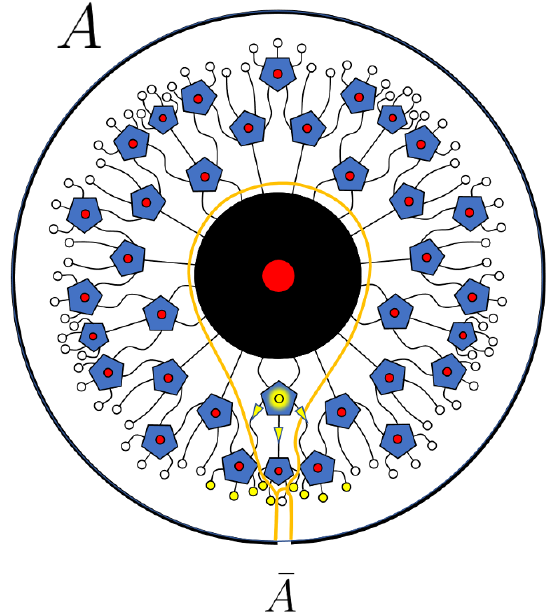
Figure 10 . Region A is now su(cid:14)ciently large that the same operator from (cid:12)gure 9, which is still in region a 0 , can now be pushed directly to the boundary without passing through the black hole. As a result it can be reconstructed on the boundary without any dependence on the state of the black